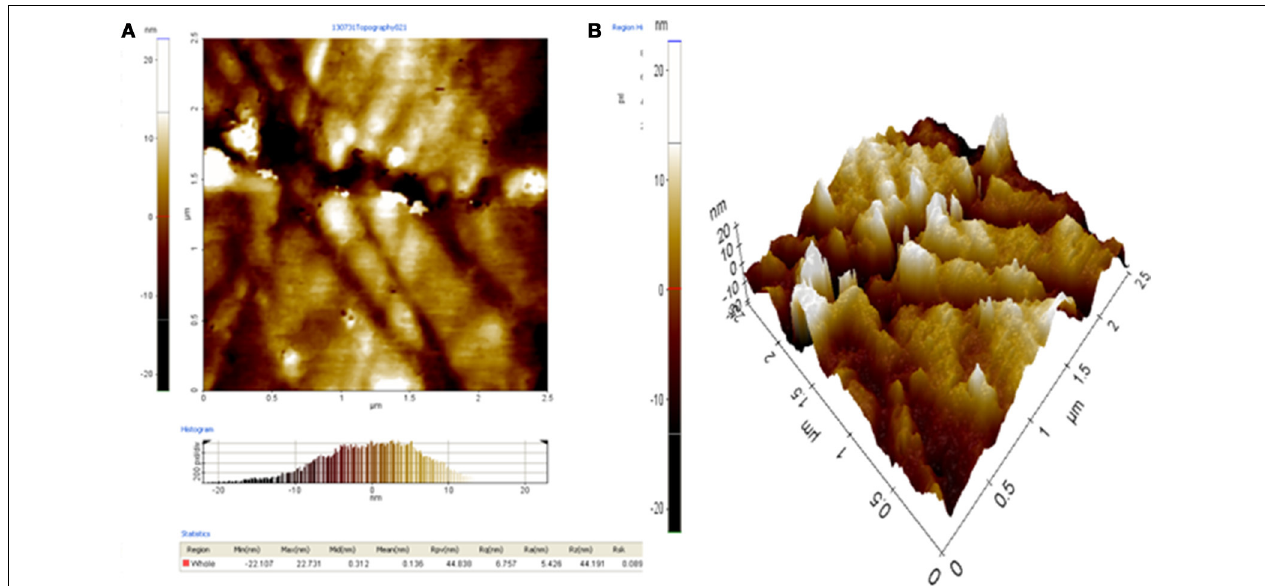
FIGURE 13 | AFM microphotographs of 1.0% RHA-DGEGBA/BMI nanocomposites (A) 2D image (B) 3D image.